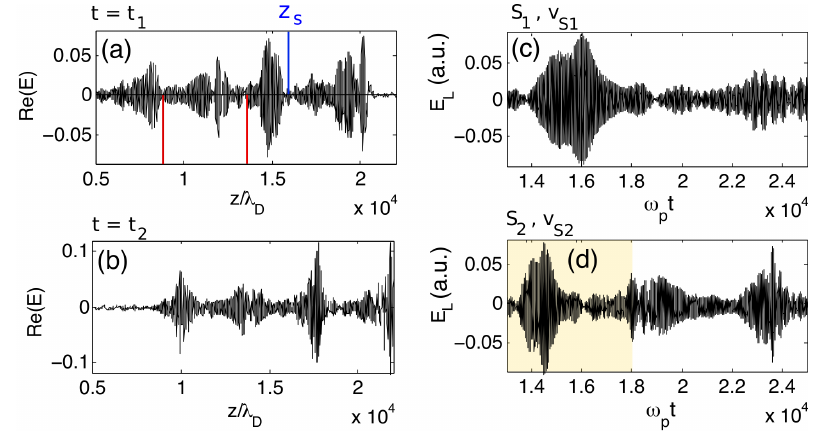
Figure 20. ( a , b ) Spatial profiles along the coordinate z / λ D of the electric field envelope Re ( E ) at times t 1 = 13,000 ω − 1 p and t 2 = 25,000 ω − 1 p . ( c , d ) Corresponding waveforms E L ( t ) observed by two virtual satellites S 1 and S 2 starting at the position z S at times t 1 and t 2 , and moving relatively to the solar wind with the velocities v S 1 and v S 2 , respectively; the position z S is indicated by an upward vertical line in ( a ), whereas the final positions of the satellites are marked by downward vertical lines; E L is normalized as the field E , and t is the time in units of ω − 1 p . Main parameters are the following: n b / n 0 = 10 − 5 , v b / v T = 18, ∆ n (cid:39)